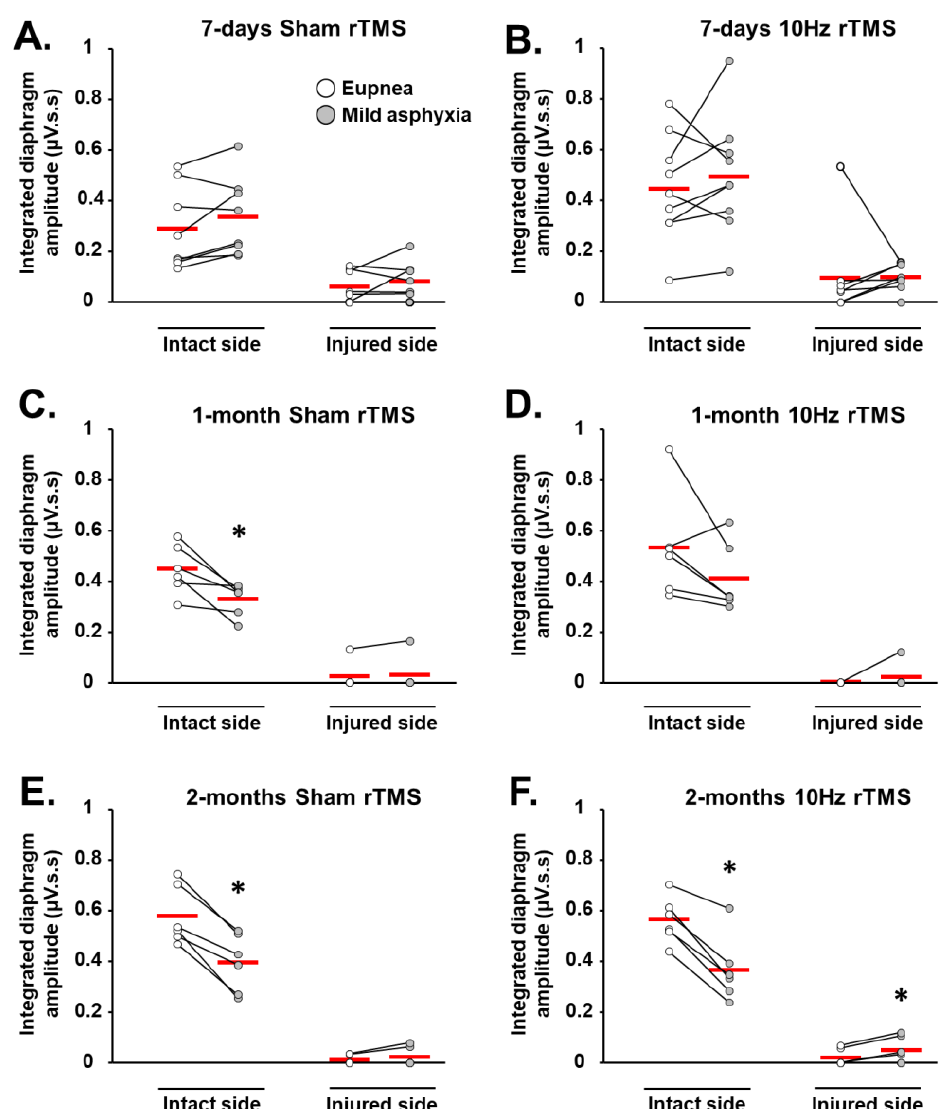
Figure 4. Diaphragm activity in C2 hemisected rats following chronic Sham and 10 Hz rTMS during respiratory challenge: integrated diaphragm amplitude for ( A ) 7-day Sham, ( B ) 7-day 10 Hz rTMS, ( C ) 1-month Sham, ( D ) 1-month 10 Hz rTMS, ( E ) 2-month Sham, and ( F ) 2-month 10 Hz rTMS groups in eupnea and during mild asphyxia. * p < 0.05 mild asphyxia, compared with eupnea (paired t -test). The red short line represent the mean